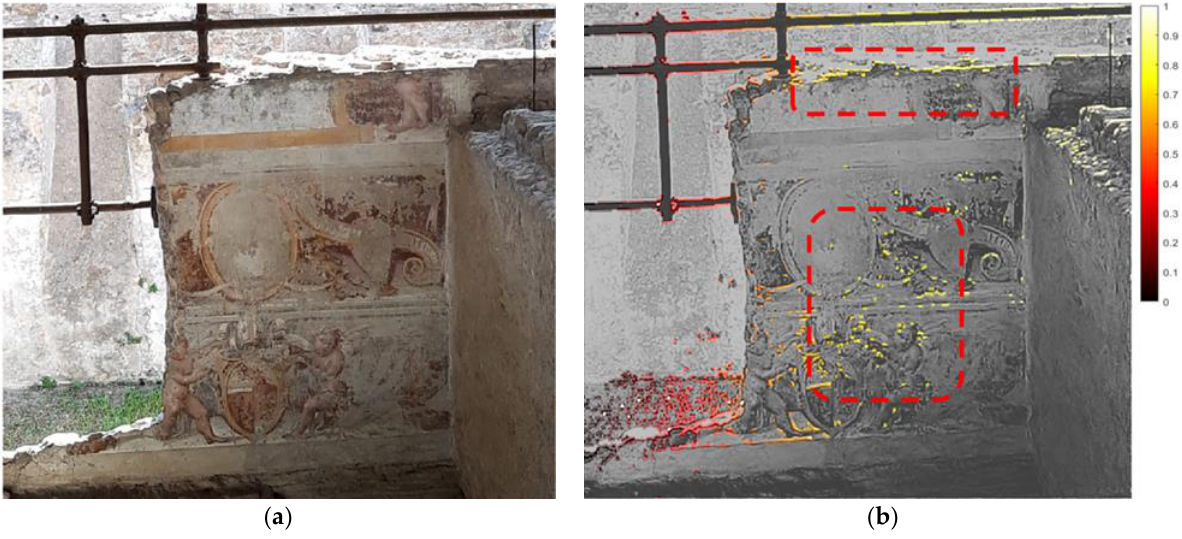
Figure 16. Relative normalized displacement pattern of a retrofitted arch: ( a ) with magnified fre- quency range 0.5 – 1.5 Hz; ( b ) with magnified frequency range 7 – 12 Hz. 7. The Colosseum The most famous monument of Rome is located in the city center where underground subway lines, tramways and road vehicles are sources of relevant vibrations. Video shoot- ing was carried out using a commercial camera, at a low frame rate (28 fps) and positioned at the considerable distance of about 100 m from the monument. In Figure 17a, a red ellipse indicates the analyzed ROI, which was selected in an area with a sharp edge in the image contrast so that a good signal for the magnification pro- cessing would be provided, as confirmed by the image entropy analysis shown in the fol- lowing. The ROI comprised a recently consolidated part of the external wall of the Colos- seum. The video was magnified at frequencies from 1 Hz to 5 Hz, corresponding to the main modes described in the literature [28,29]. Visual inspection of the magnified videos con- firmed that the ROI area provided a higher response at the lowest frequencies in the ana- lyzed range, corresponding to the first mode at 1.03 Hz. Consequently, the MM analyses